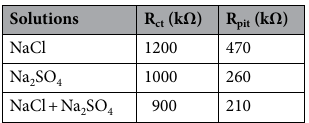
Table 4. The EIS parameters of copper electrode (3.14mm 2 ) at 60 °C.